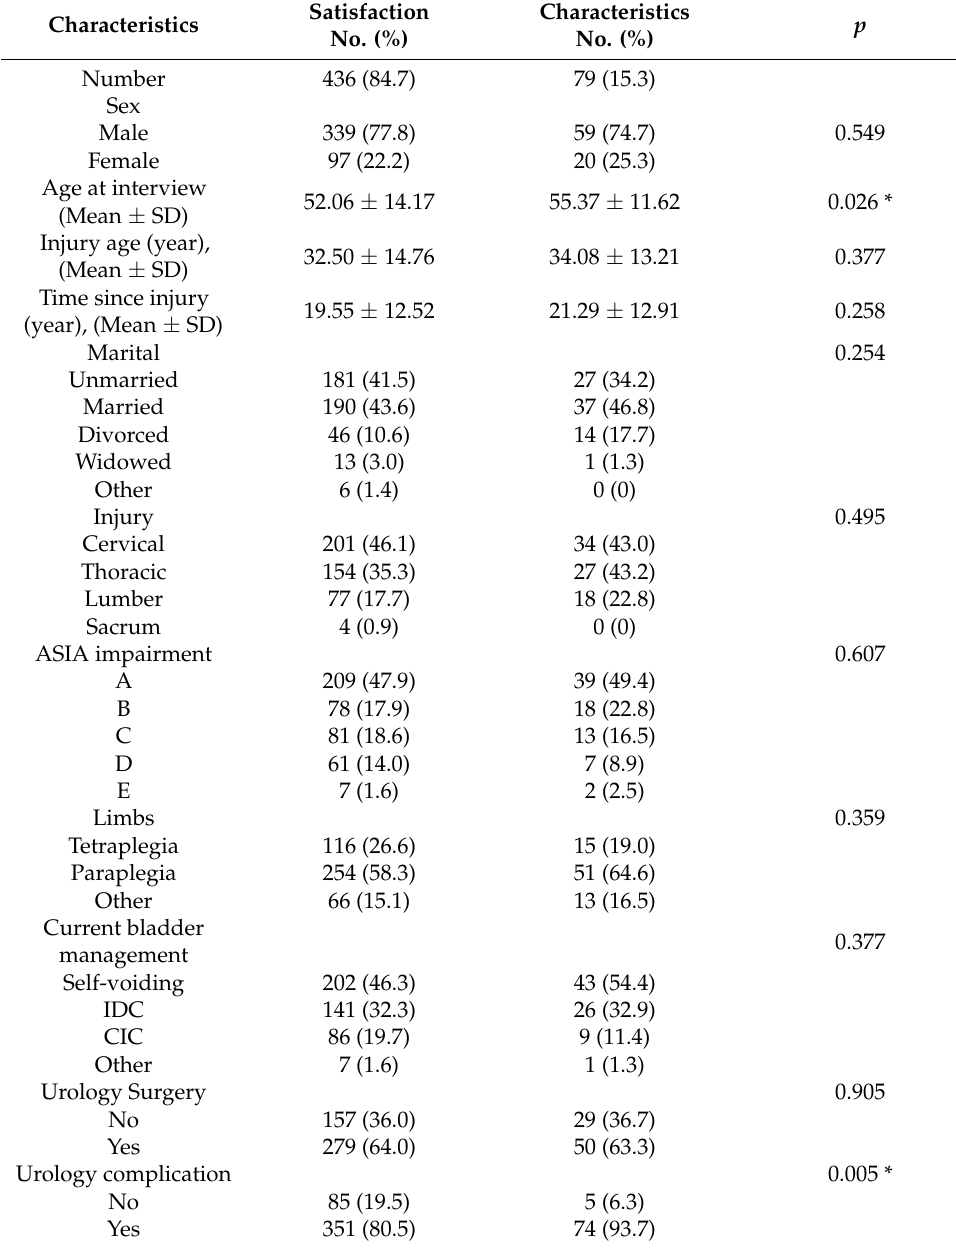
Table 2. Patients’ satisfaction with current bladder management ( n =